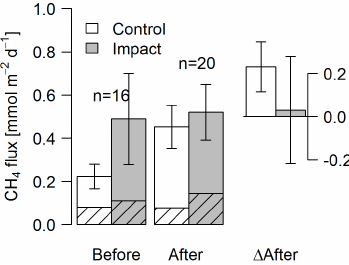
Figure 7. Fluxes of CH 4 by diffusion (shaded) and ebullition (non- shaded) across the lake–atmosphere interface in control and impact catchments before and after forest clear-cutting, and the respective differences between before and after ( (cid:49) After, shown in the same units). Fluxes were measured by the use of flux chambers (e.g., in- dependent approach compared to fluxes calculated from concentra- tions in Fig. 6). Each bar represents mean values ( ± propagated stan- dard errors) of whole-lake fluxes measured weekly from mid-June to mid-August 2012 and 2014, summarized as arithmetic means over ten bootstrap runs that take between-chamber variability into account (see Fig. S3 and Text S6). Whole-lake fluxes are the area- weighted mean of depth-zone specific fluxes. Abbreviations: n is the number of